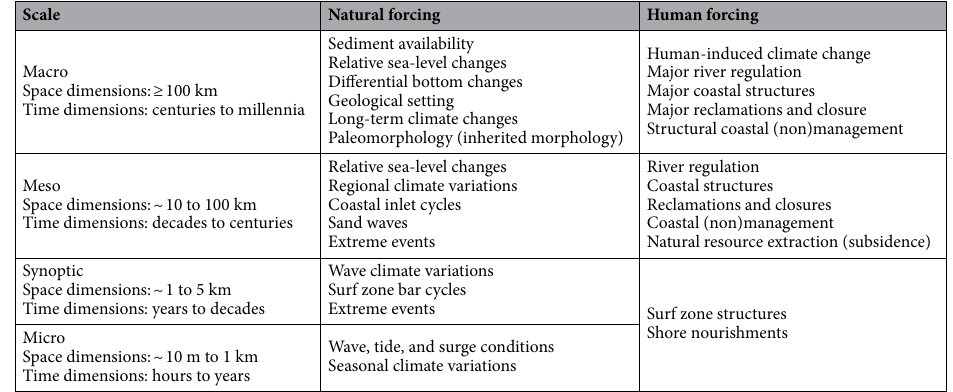
Table 1. External forcings associated with each established scale of shoreline evolution (adapted from 20,51